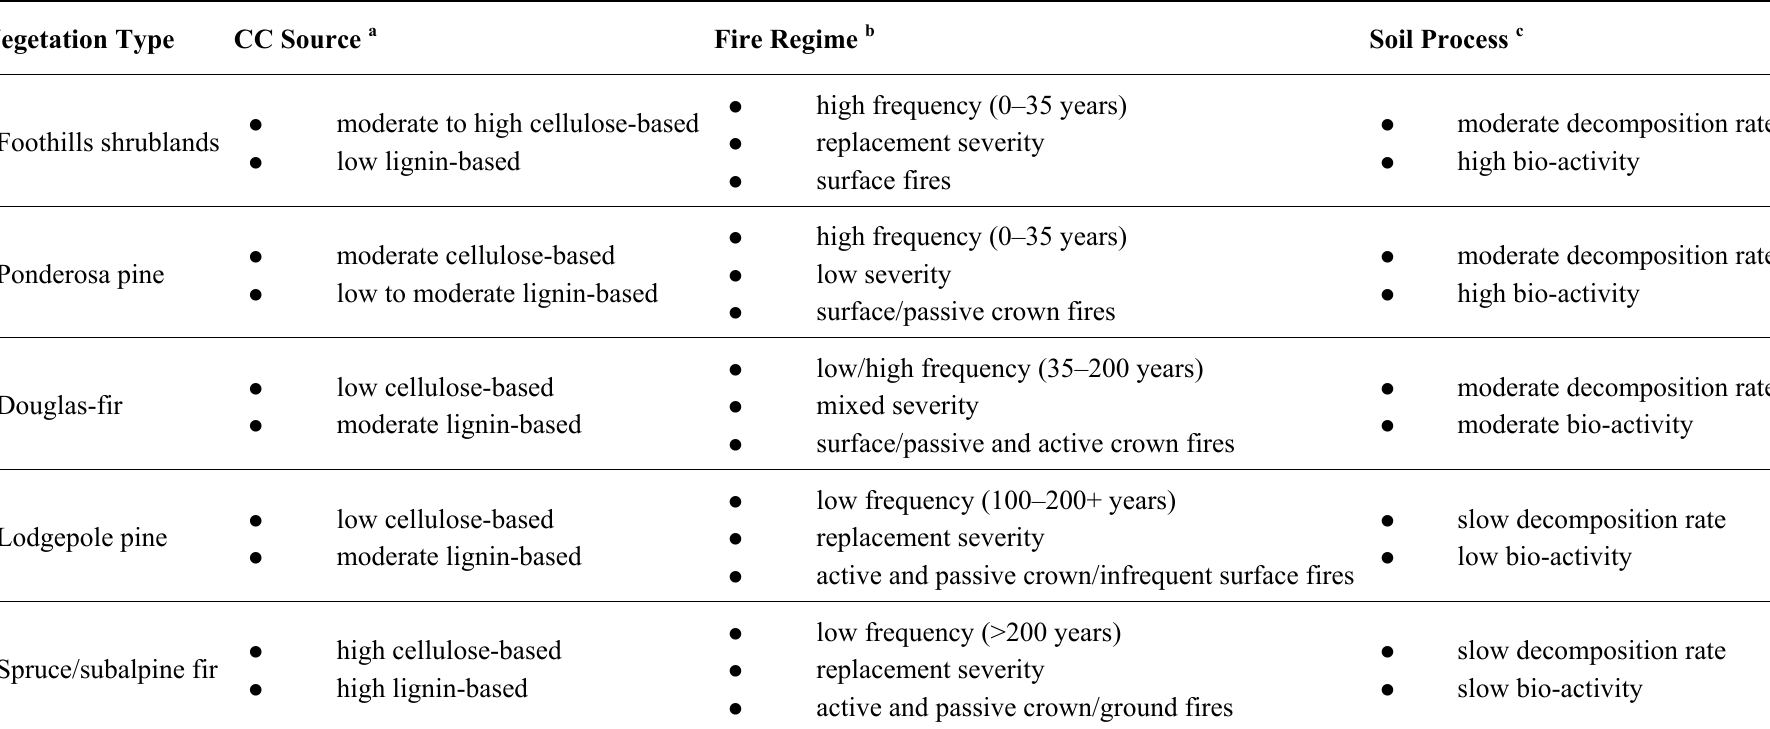
Table 2. Generalized charcoal sources, fire regimes and soil processes that influence soil charcoal carbon (CC) pools across five vegetation types along an ecological gradient in the Colorado Front